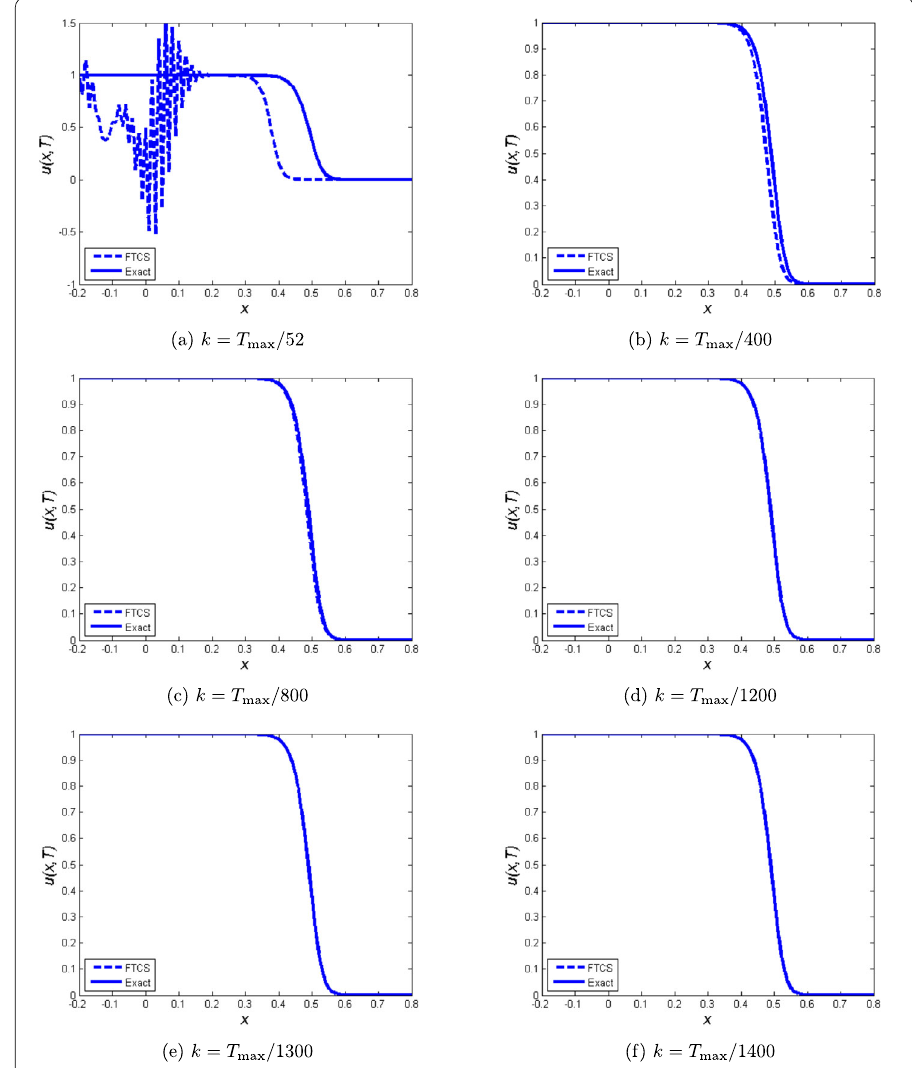
Figure 1 Plot of u against x for Problem 1 using FTCS scheme at time 2.5 × 10 –3 at some different values of k and h = 0.01, T max = 2.5 × 10